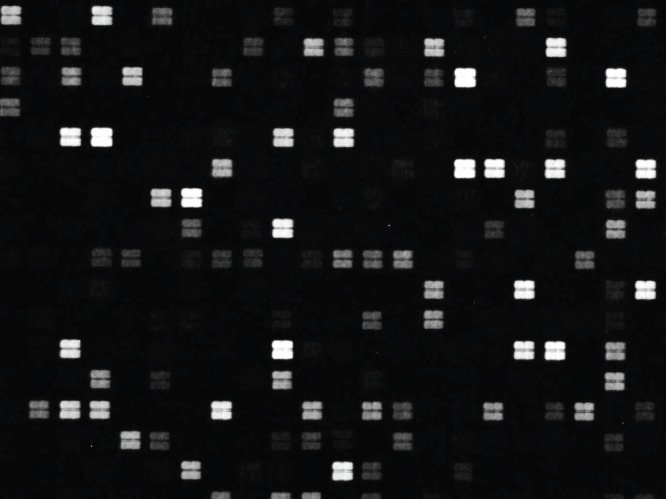
Image of array.A small section of the peptide array used for identification and fine specificity mapping of HSA epitopes: The section shows approximately 300 of the total 220.428 peptide fields in this array. The peptides were synthesized in predefined, addressable fields generated by 2×2 mirrors on the DMD each measuring 10×10 µm resulting in peptide fields with the size 20×20 of µm. The peptide fields were spaced by 10 µm wide empty zones. Binding of polyclonal rabbit anti-HSA antibody to the fields was recorded by fluorescence microscopy after incubation with Cy3-conjugated goat anti-rabbit IgG.